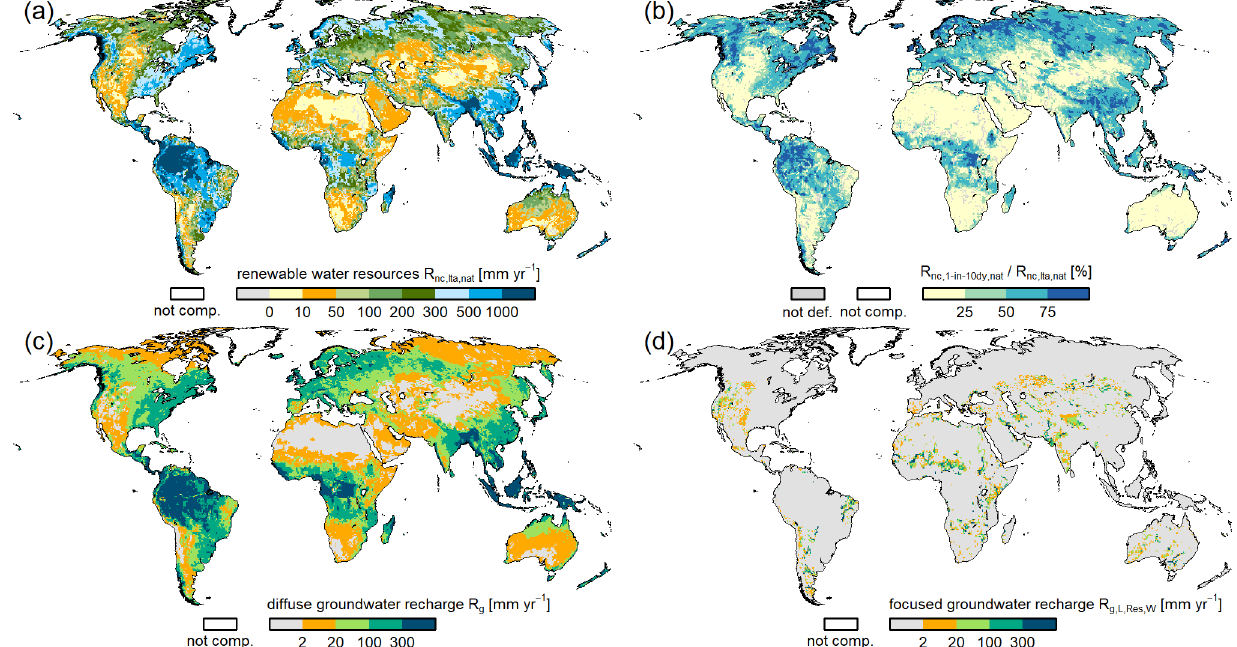
Figure 11. Water resources assessment 1981-2010 using WaterGAP 2.2d, with (a) total renewable water resources defined as long-term annual net cell runoff R nc , lta , nat [ mmyr − 1 ] , (b) 1-in-10 dry-year runoff generation in percent of total renewable water resources [ % ] , (c) long- term annual diffuse groundwater recharge R g [ mmyr − 1 ] , (d) long-term annual focused groundwater recharge R g are based on naturalized model runs. In (a) note that negative values for total water resources are possible (Sect. 4.7.3). In (b) areas where the denominator is < 10 − 5 are labeled as not